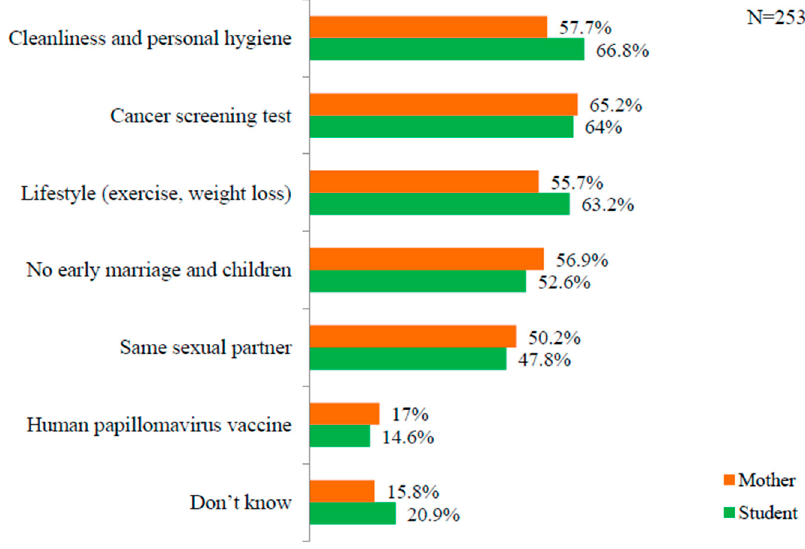
Figure 2. Knowledge of mothers and students about the prevention of cervical cancer.